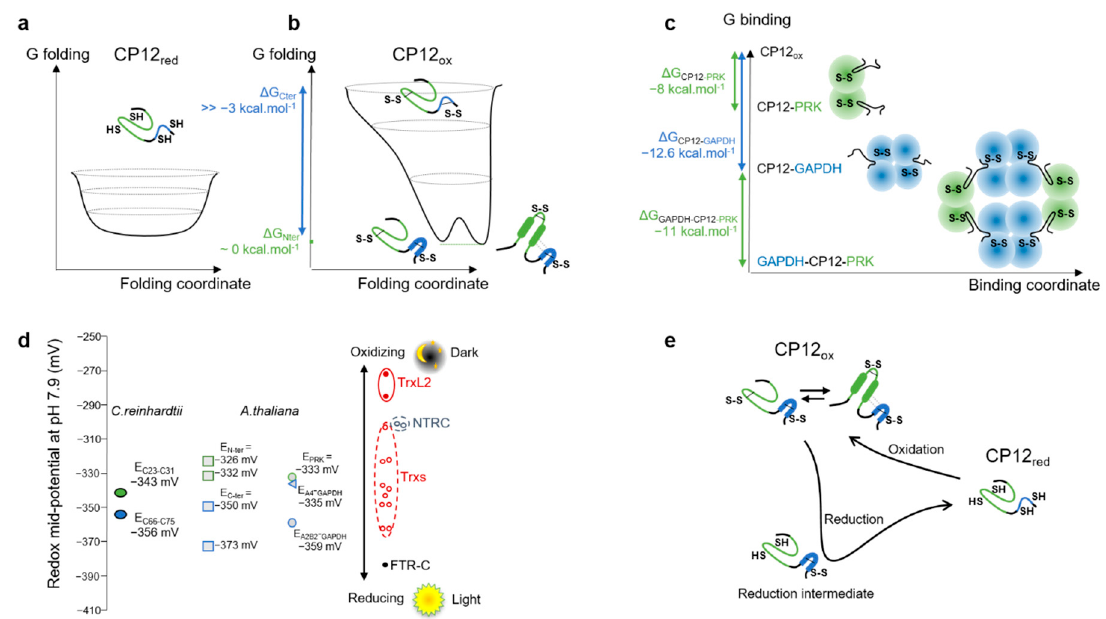
Figure 7. Overview of the thermodynamic equilibria of CP12. ( a ) Gibbs free energy of folding for CP12 red . ( b ) Simplified Gibbs free energy of folding for CP12 ox , refer to Figure 3e,f. ( c ) Gibbs free energy of binding for CP12 ox . ( d ) The midpoint redox potentials for the CP12 C -terminal disulfide bridge (blue circle) and N -terminal disulfide bridge (green circle) measured in this study are compared to the midpoint potential for A. thaliana CP12 isoforms (blue and green squares), as well as for A 2 B 2 -GAPDH, A 4 -GAPDH, and PRK activity as determined in [63–65] (blue open triangle, blue open circle, and green open circle, respectively). For comparison, the redox potential of the ferredoxin-Trx reductase C -subunit (FTR-C) is shown in black, that of the NADPH-Trx reductase C (NTRC) in open blue circles, various Trx isoforms in red, as well as that of the Trx like 2 (TrxL2), as in Yoshida et al. [66]. ( e ) Kinetics of the oxidation (right to left) and reduction (left to right) highlighting the synchrony of the first, and the existence of a reduction intermediate for the second.